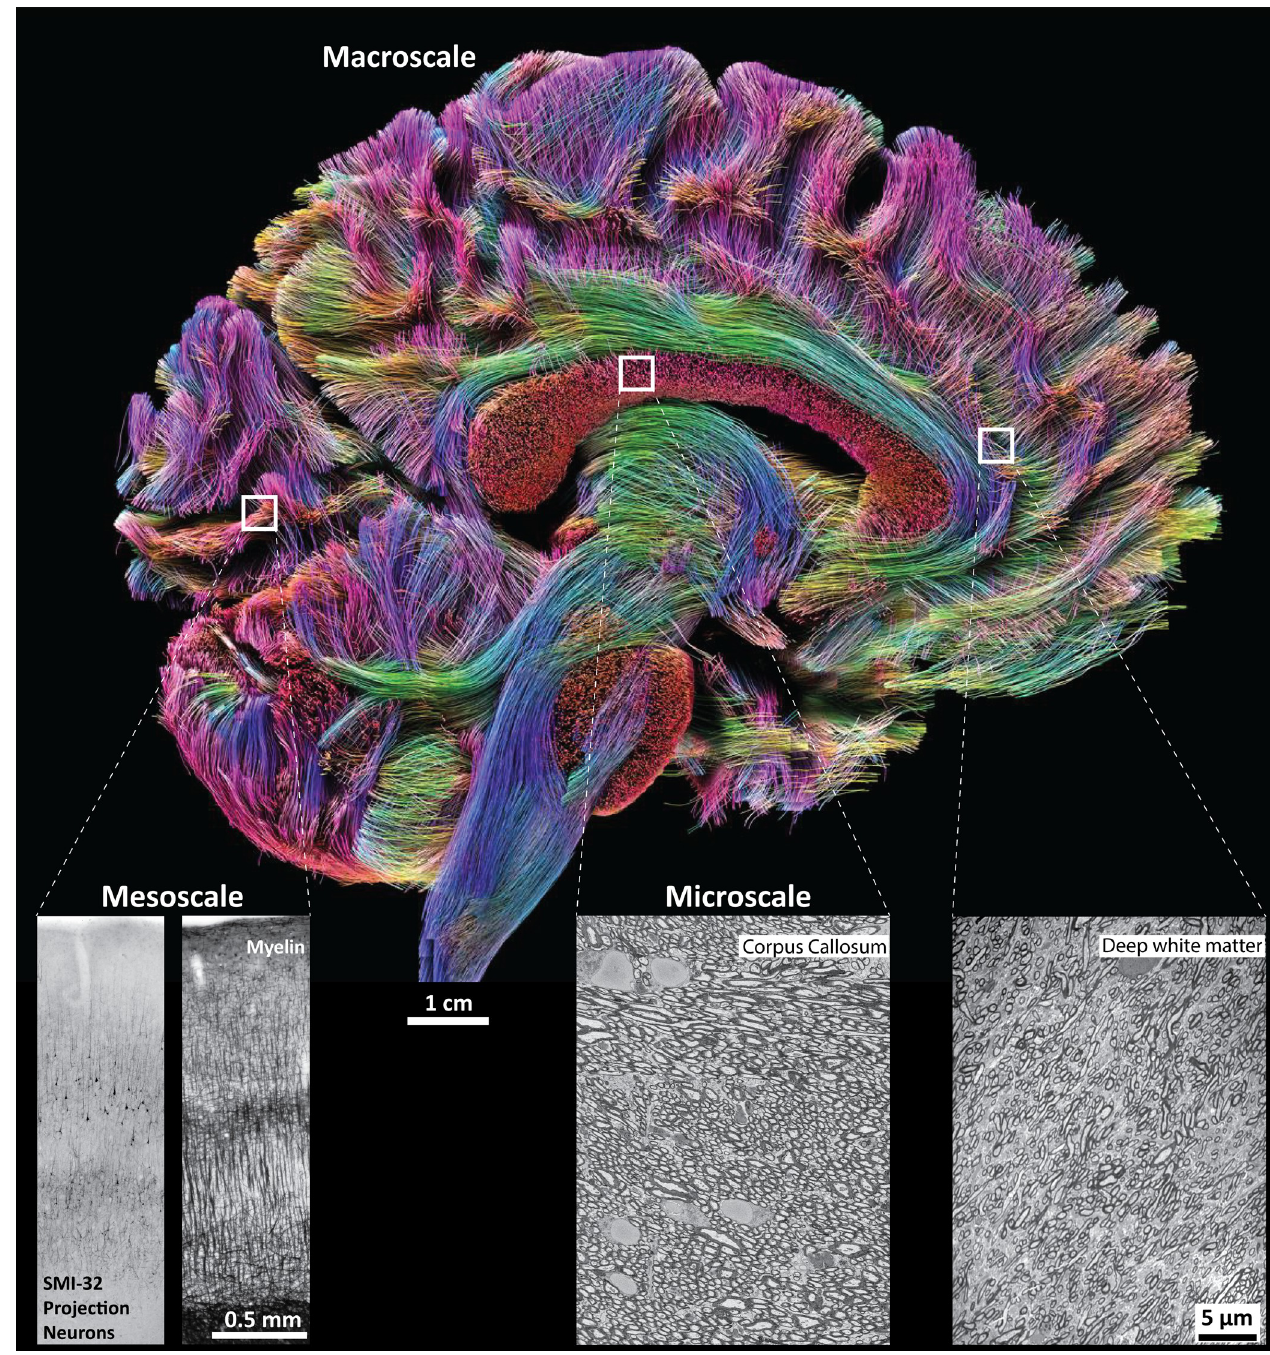
Fig 1. Integrating human brain connectivity at the macro, meso and micro scale. MR diffusion tractography is a widely used non-invasive method for the macroscopic estimation of anatomical connections in the living human brain (macroscale, top image). Higher resolution, albeit invasive, tractography approaches can only be used in animal model systems or with post-mortem human brain tissue to study projection neurons and axon bundles at the cellular level (mesoscale, bottom left panels of cortical columns in visual cortex labelled with non-phosphorylated intermediate neurofilament protein SMI-32 or with the Gallyas myelin stain). To study individual axons and synaptic interactions between connected neurons and areas one needs to use ultra-high resolution approaches and visualize brain tissue under the electron microscope (microscale, two bottom right panels of myelinated axons in the corpus callosum and deep white matter below the cingulate cortex). By comparing macroscopic counts of MR diffusion streamlines with microscopic counts of axons passing through the corpus callosum, Rosen and Halgren [4] derived a conversion factor that can be applied to tractography data in order to estimate the absolute number of axons in a given tract. However, caution needs to be applied when translating the factor from the well-ordered callosal connections to more heterogeneous non-